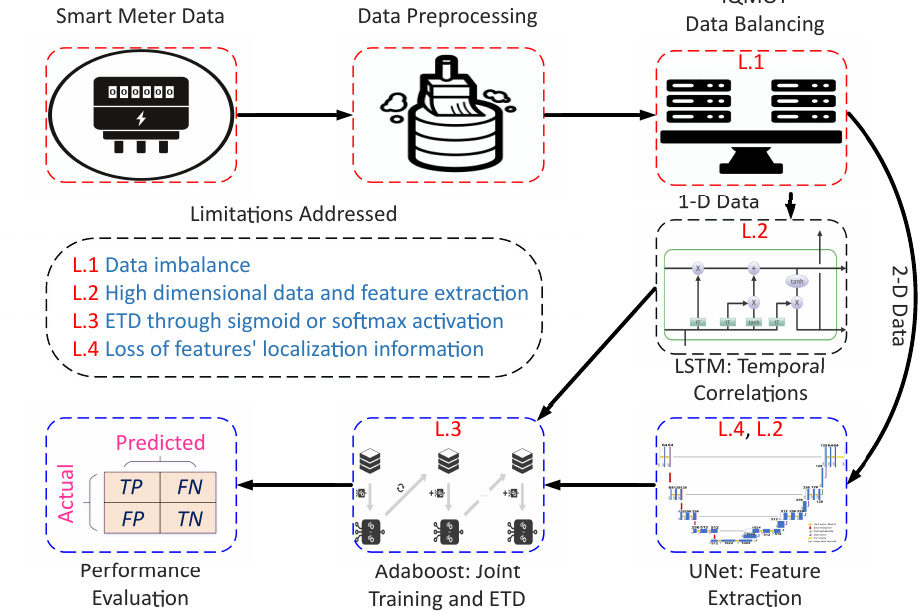
Figure 1. Overview of the proposed system model for electricity theft detection